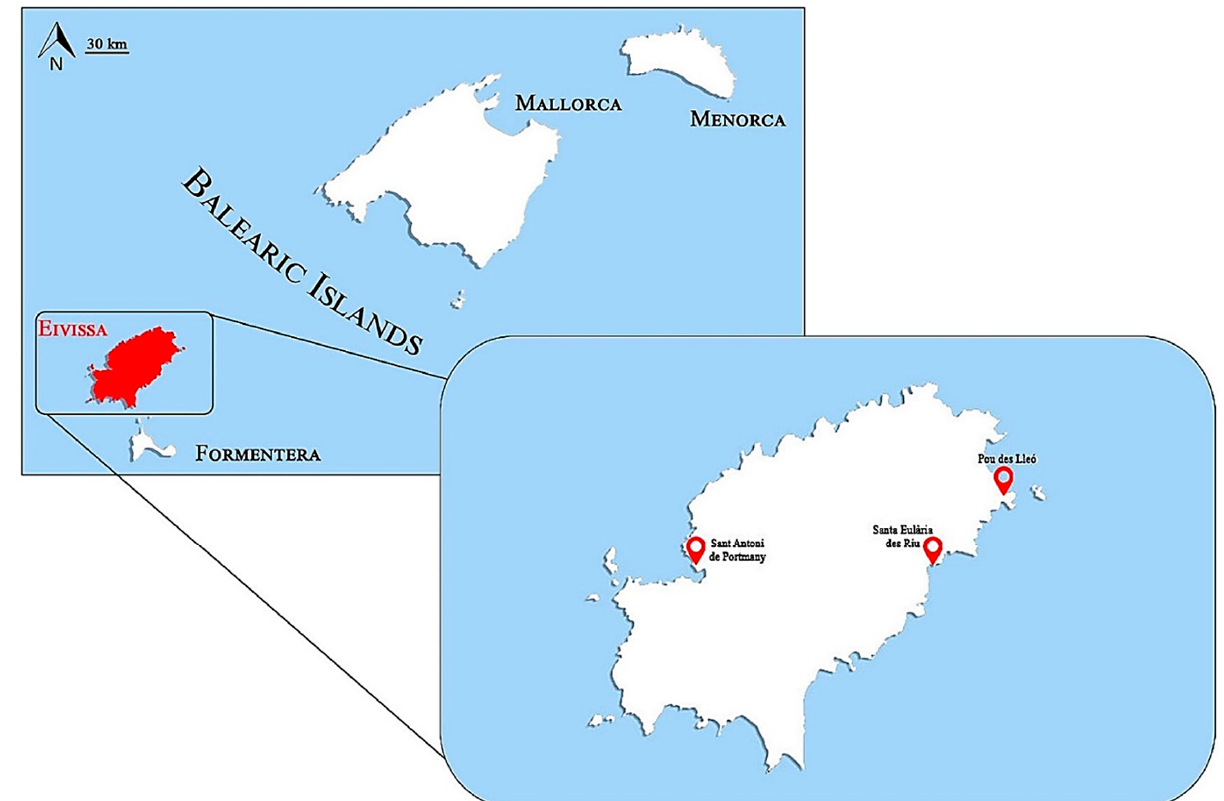
Figure 8. Map of the geographic localization of Balearic Islands with the names of the four principal islands. Eivissa Island is indicated in red and, in the inset map, the areas of the three sampling stations (Sant Antoni de Portmany, Santa Eulària des Riu, and Pou des Lleó) are indicated.